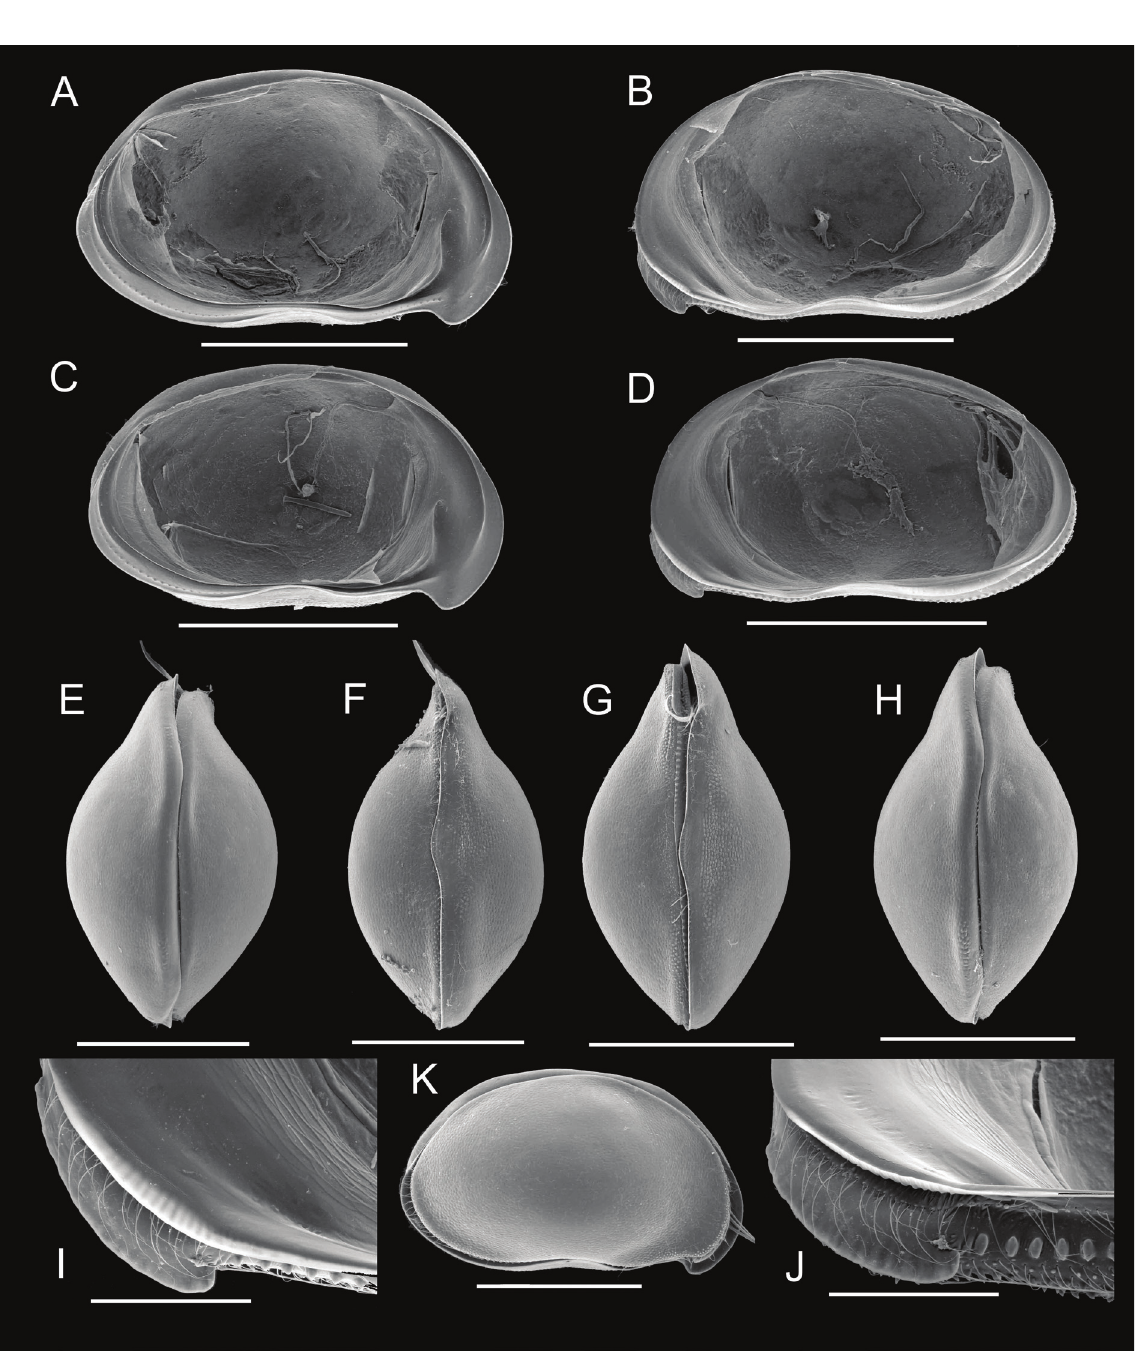
Fig. 19. Bennelongia bidgelangensis sp. nov. (all from Bidgelang Pool, type locality). A . LVi (allotype ♀, WAM.C49413). B . RVi (♀, Idem). C . LVi (holotype ♂, WAM.C49412). D . RVi (♂, Idem). E . Cp dorsal (♀, WAM.C49415B). F . Cp ventral (♀, WAM.C49415C). G . Cp ventral (♂, WAM.C49415A). H . Cp dorsal (♂, Idem). I . RVi (detail anteriorly, holotype ♂, WAM.C49412). J . rVi (detail anteriorly, tilted, ♂, Idem). K . Cp RL (♀, WAM.C49415D). Scales: A-H, K = 500 µm; I, J = 200